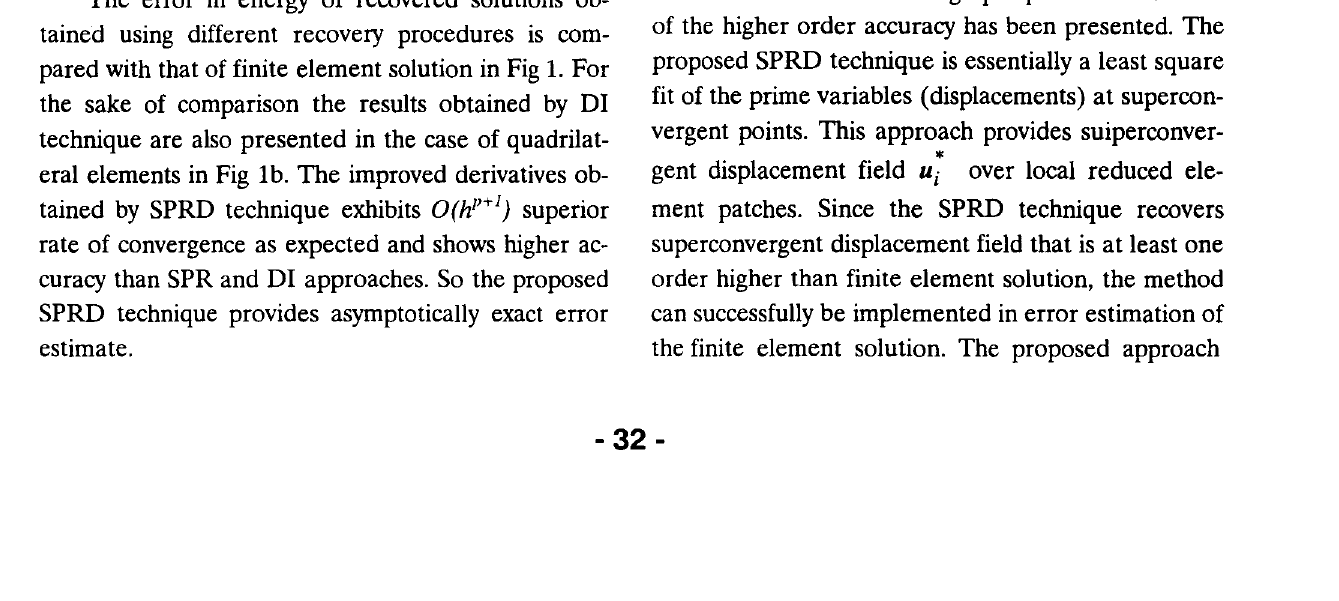
Fig 1. Convergence of the energy norm of error In Figs 2 and 4, the point-wise error distribution of the derivative component cr.. is shown obtained us ing the finite element method and recovery ap proaches SPR and SPRD using linear quadrilateral and triangular